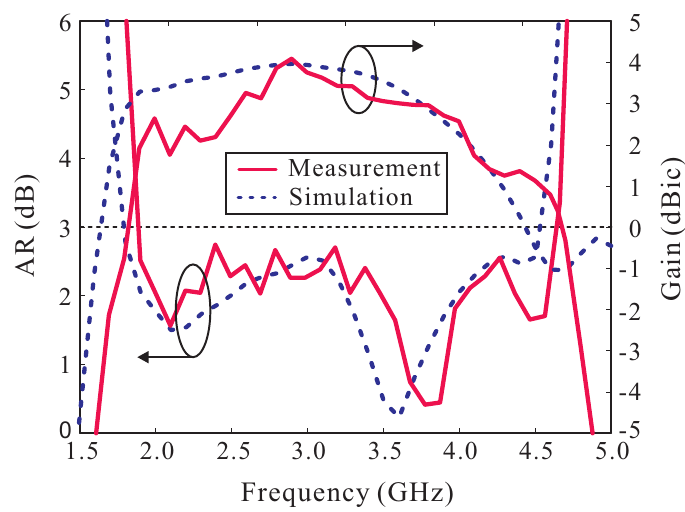
Figure 8. Simulated and measured ARs, and left-handed circular polarization (LHCP) gains versus frequency.